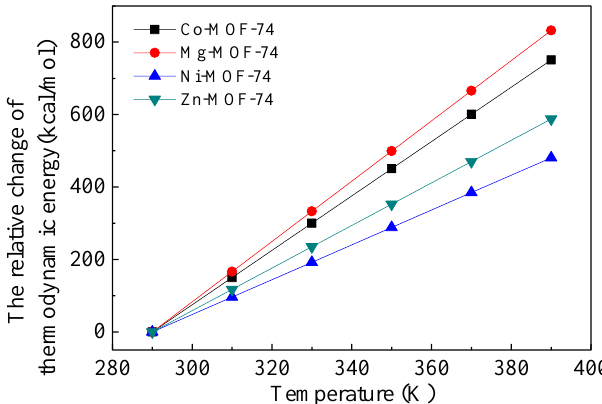
Figure 4. Variation of the relative change of the thermodynamic energy of M-MOF-74 with temperature, with M denoting Co, Mg, Ni and Zn.